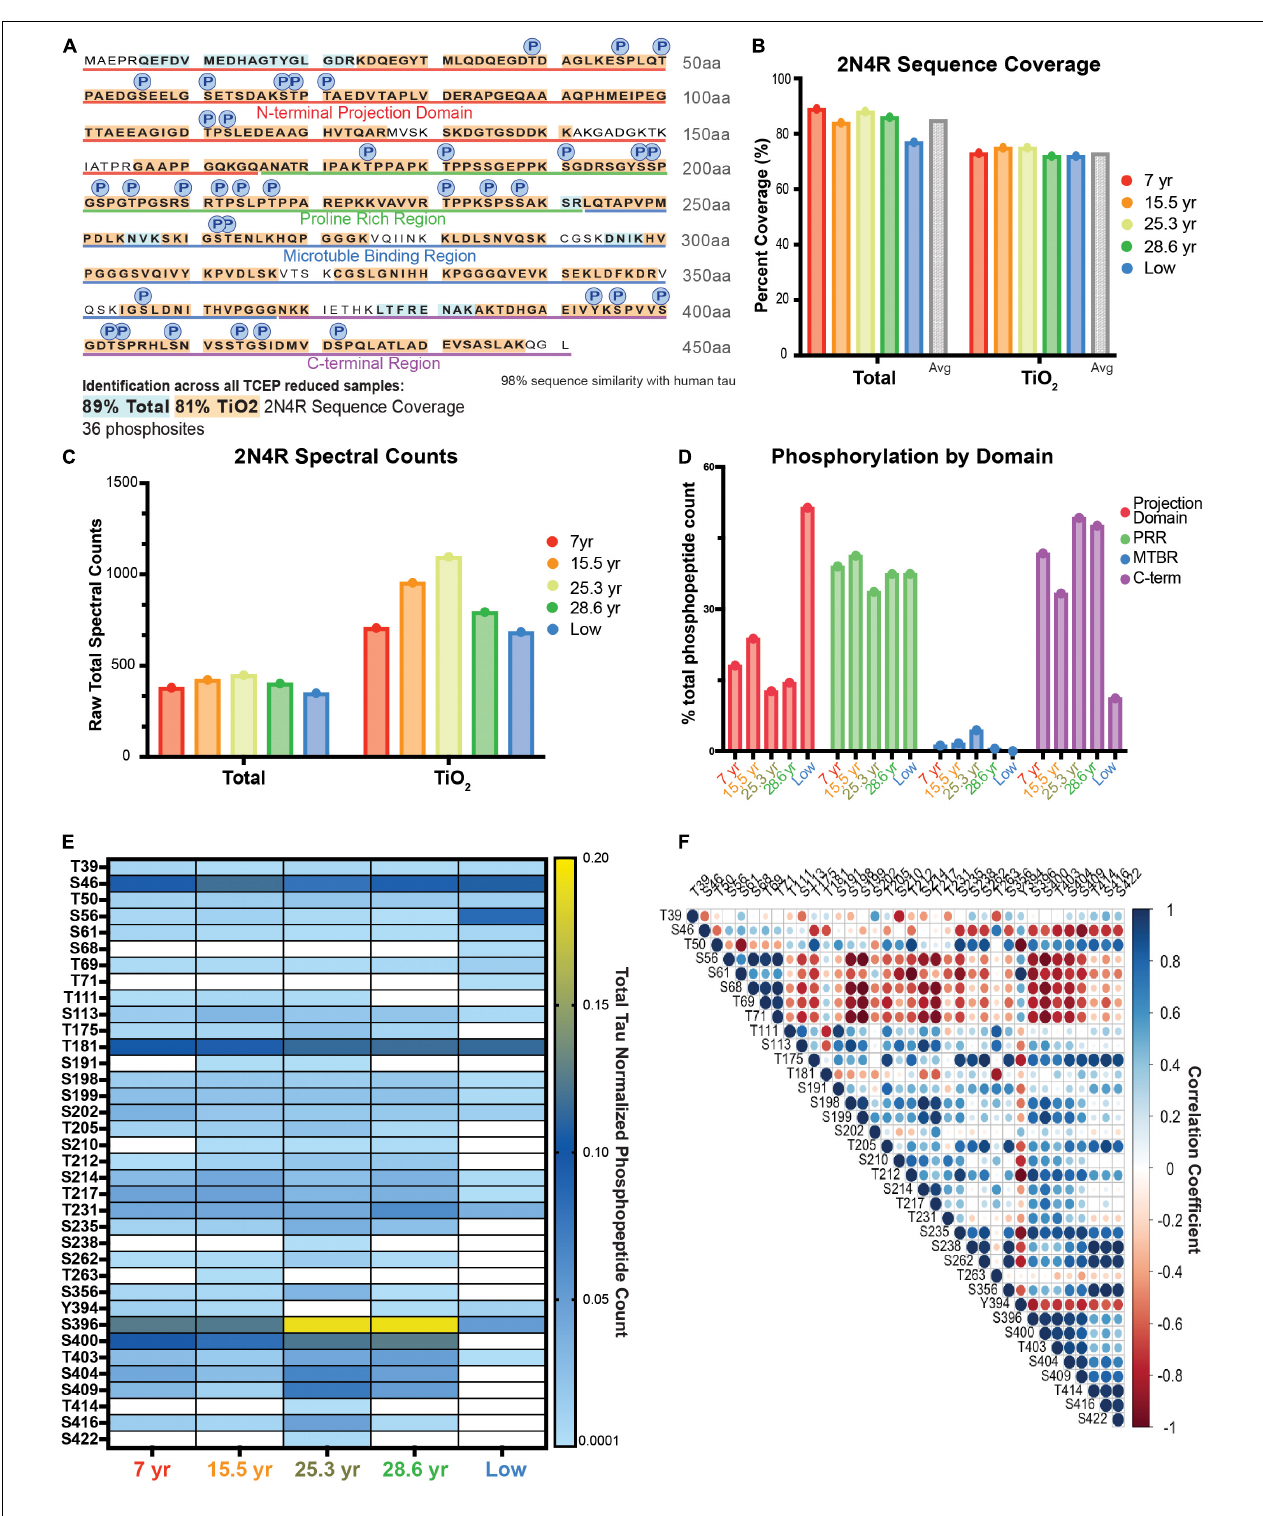
FIGURE 2 | Analysis of age-related changes in monkey heat stable tau via single-shot LC-MS. (A) Coverage map of 2N4R isoform of tau from all TCEP reduced samples (ten samples total, five unenriched samples, five TiO 2 enriched samples). Amino acids represented in the total, unenriched lysate only, are highlighted in blue. Those identified in both unenriched and TiO 2 enriched samples are highlighted in orange. 36 unique phosphosites were detected and are identified by a circle